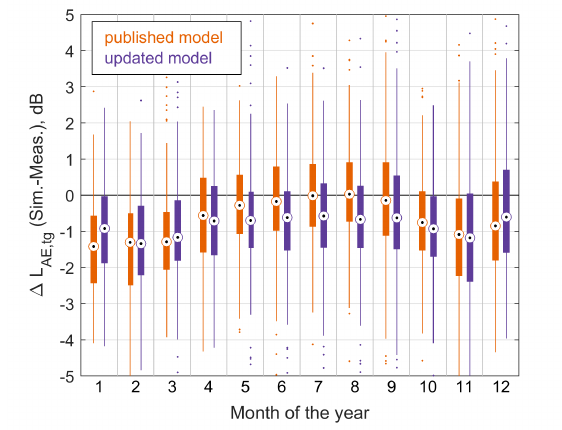
Figure 5: Comparison of inter-annual trends in departure event level differences modelled with published (orange) and updated (purple) full model